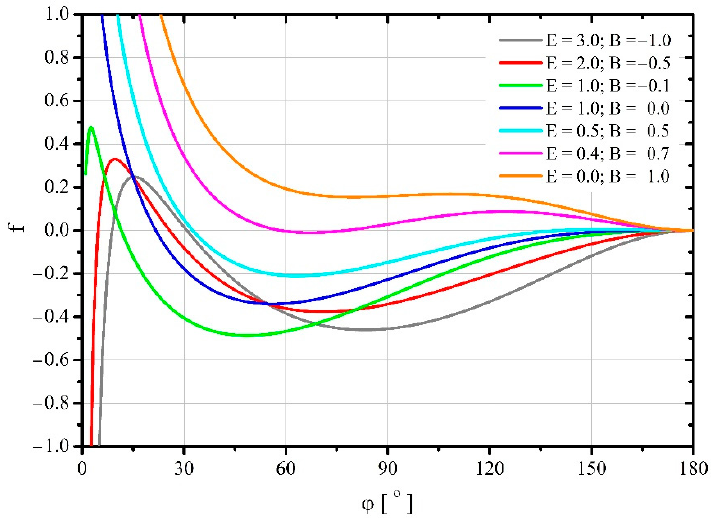
Figure 6. Changes in dimensionless free energy in a system in which there is no force acting along the three—phase contact line causing its stretching or shrinking ( 𝐷 = 0 ).